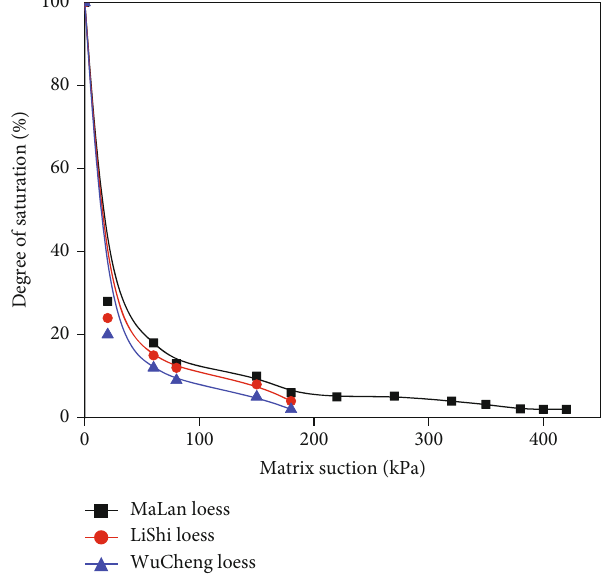
Figure 5: Soil-water characteristic curve.